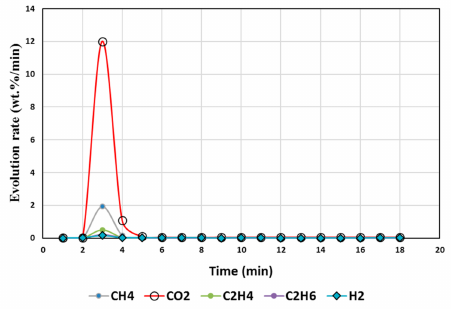
Figure 4. Gas Chromatography results of isothermal calcination of magnesite + biomass (Test 5, MgCO 3 · xH 2 O; biomass) at 1000 ◦